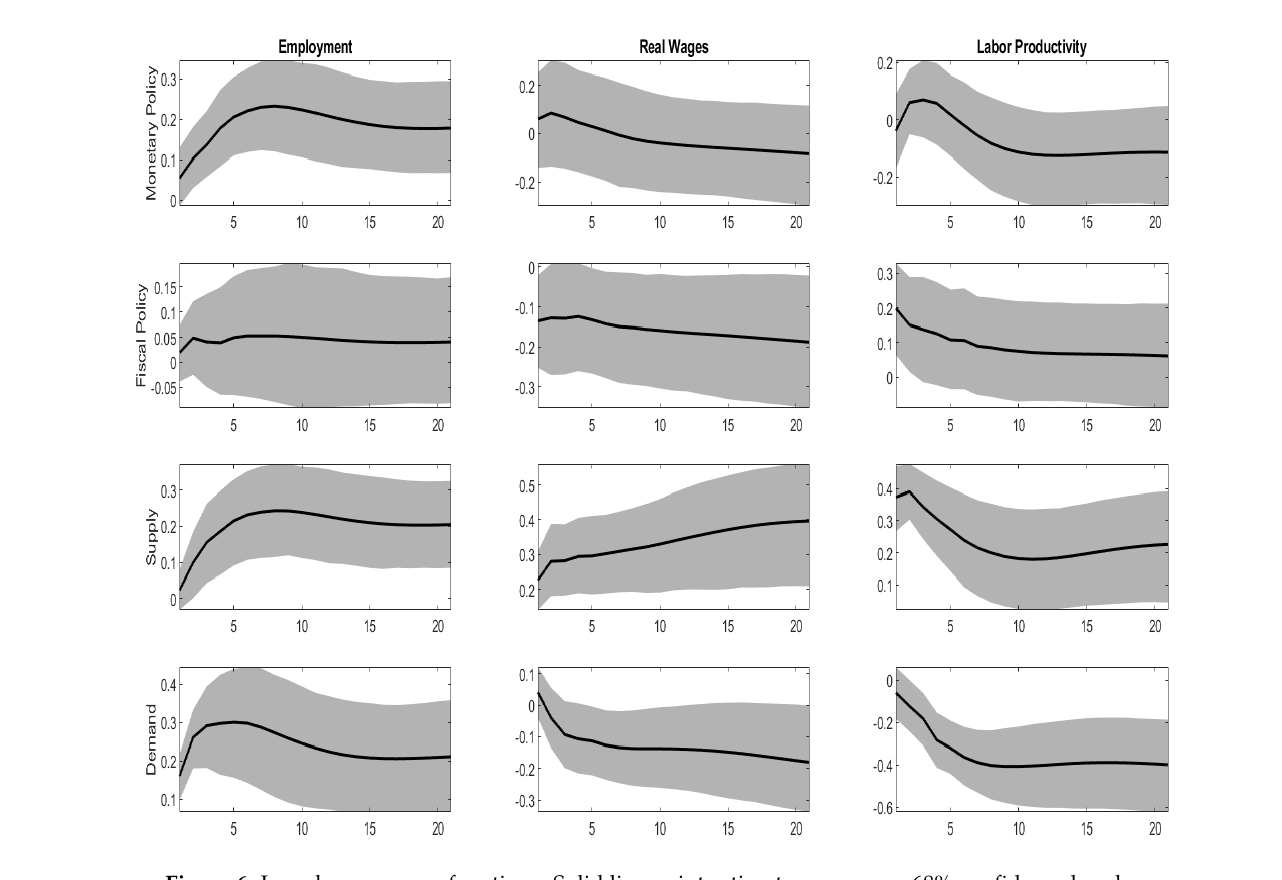
Figure 6. Impulse-response functions. Solid line point estimate, gray areas 68% confidence